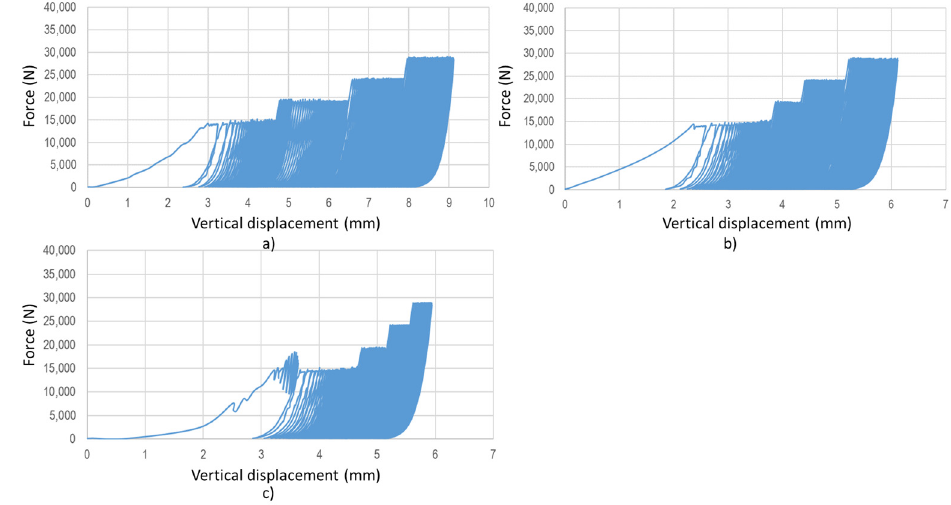
Figure 5. Force–vertical displacement curves for selected samples of the CBGM with ( a ) 3%, ( b ) 5%, and ( c ) 7% cement content.